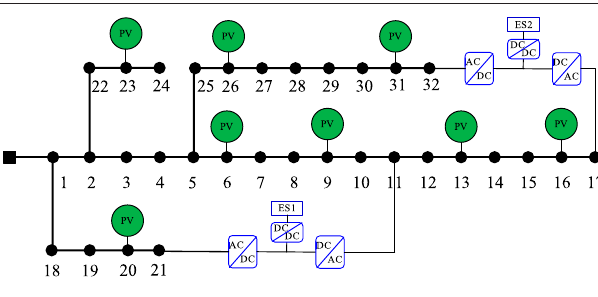
FIGURE 3 | IEEE 33-node system with SOP-based ES and PV generations.